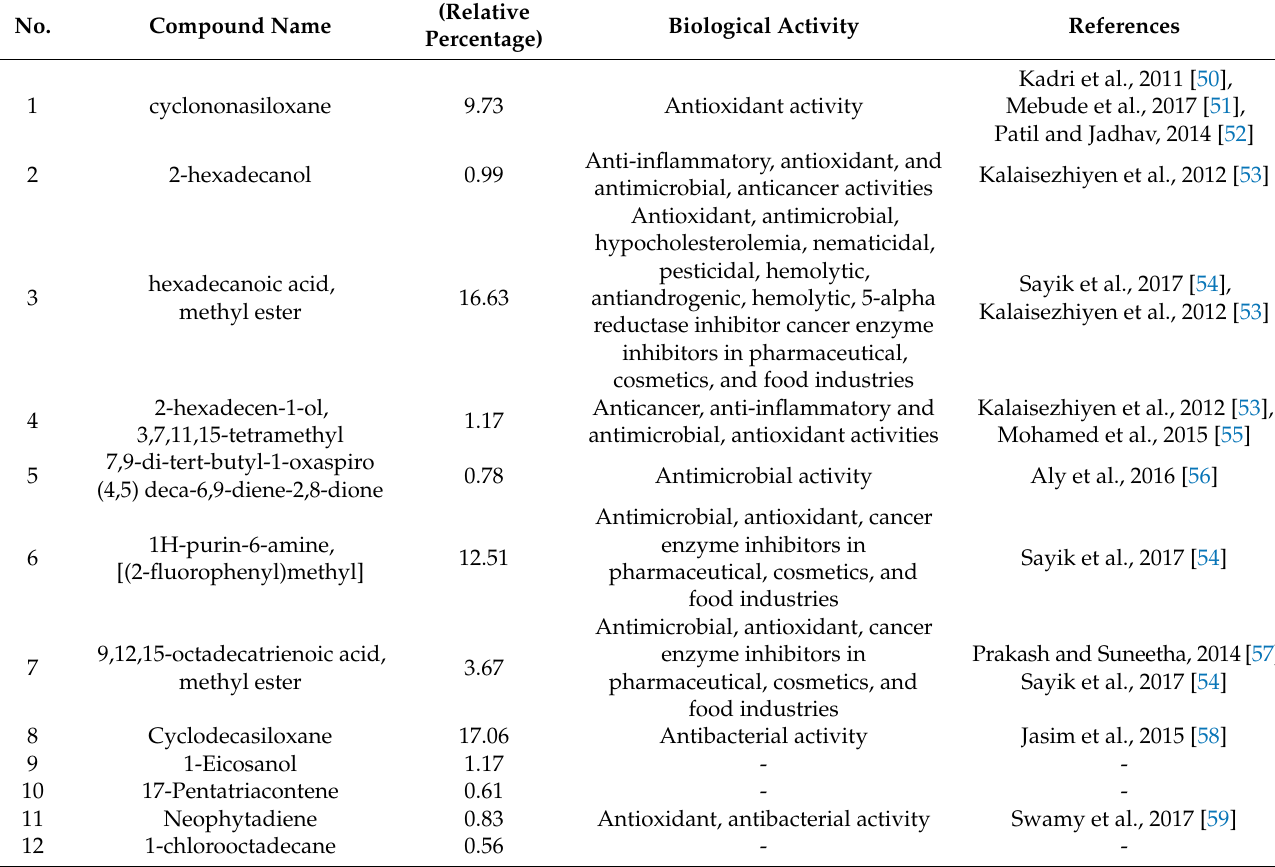
Figure 1. Antioxidant activity Nostoc linckia extract (0.44 mg/L of Zn) against ABTS radical at pH values 3,5,7,8,10 and 12. Table 10. GC/MS analysis for most effective extract (0.44 mg/L Zn) of Nostoc linckia (as